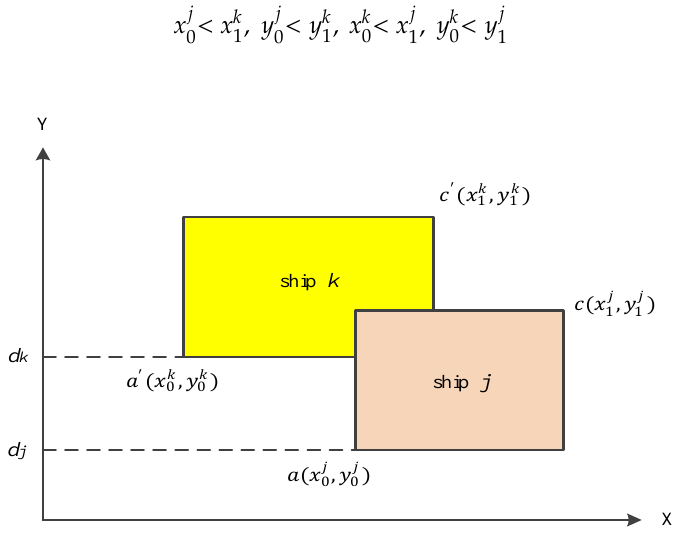
Figure 7. The coordinates of the corner points of ships j and k.